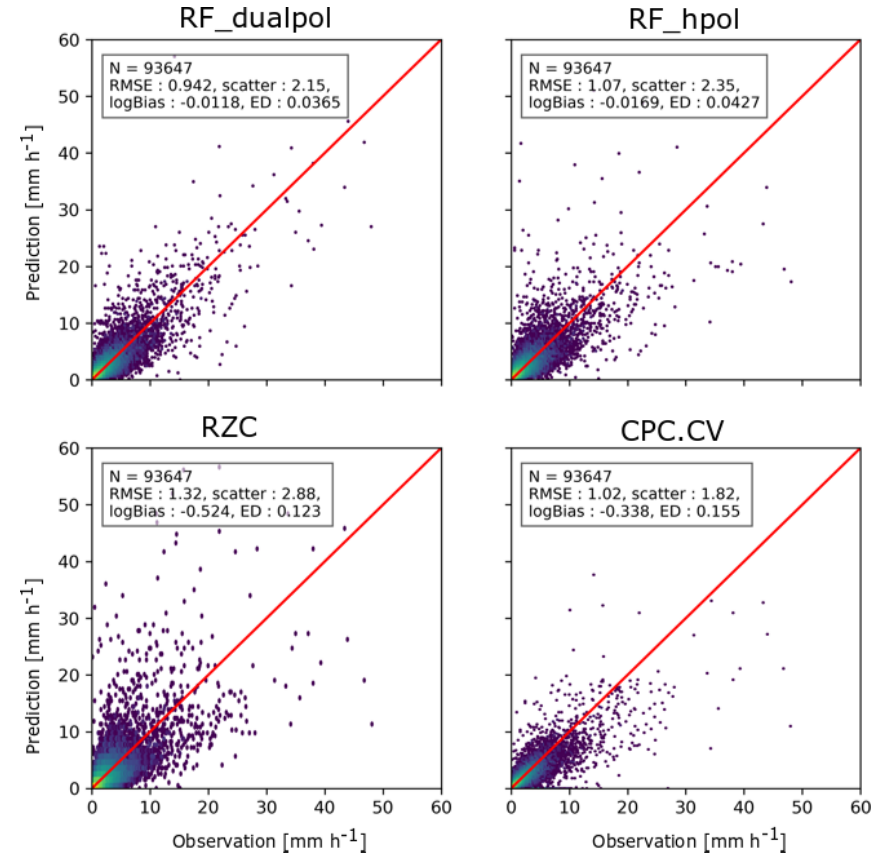
Figure 9. Example of prediction versus observation scatter plots on the test fraction for one cross-validation iteration. The 1 : 1 line is shown in